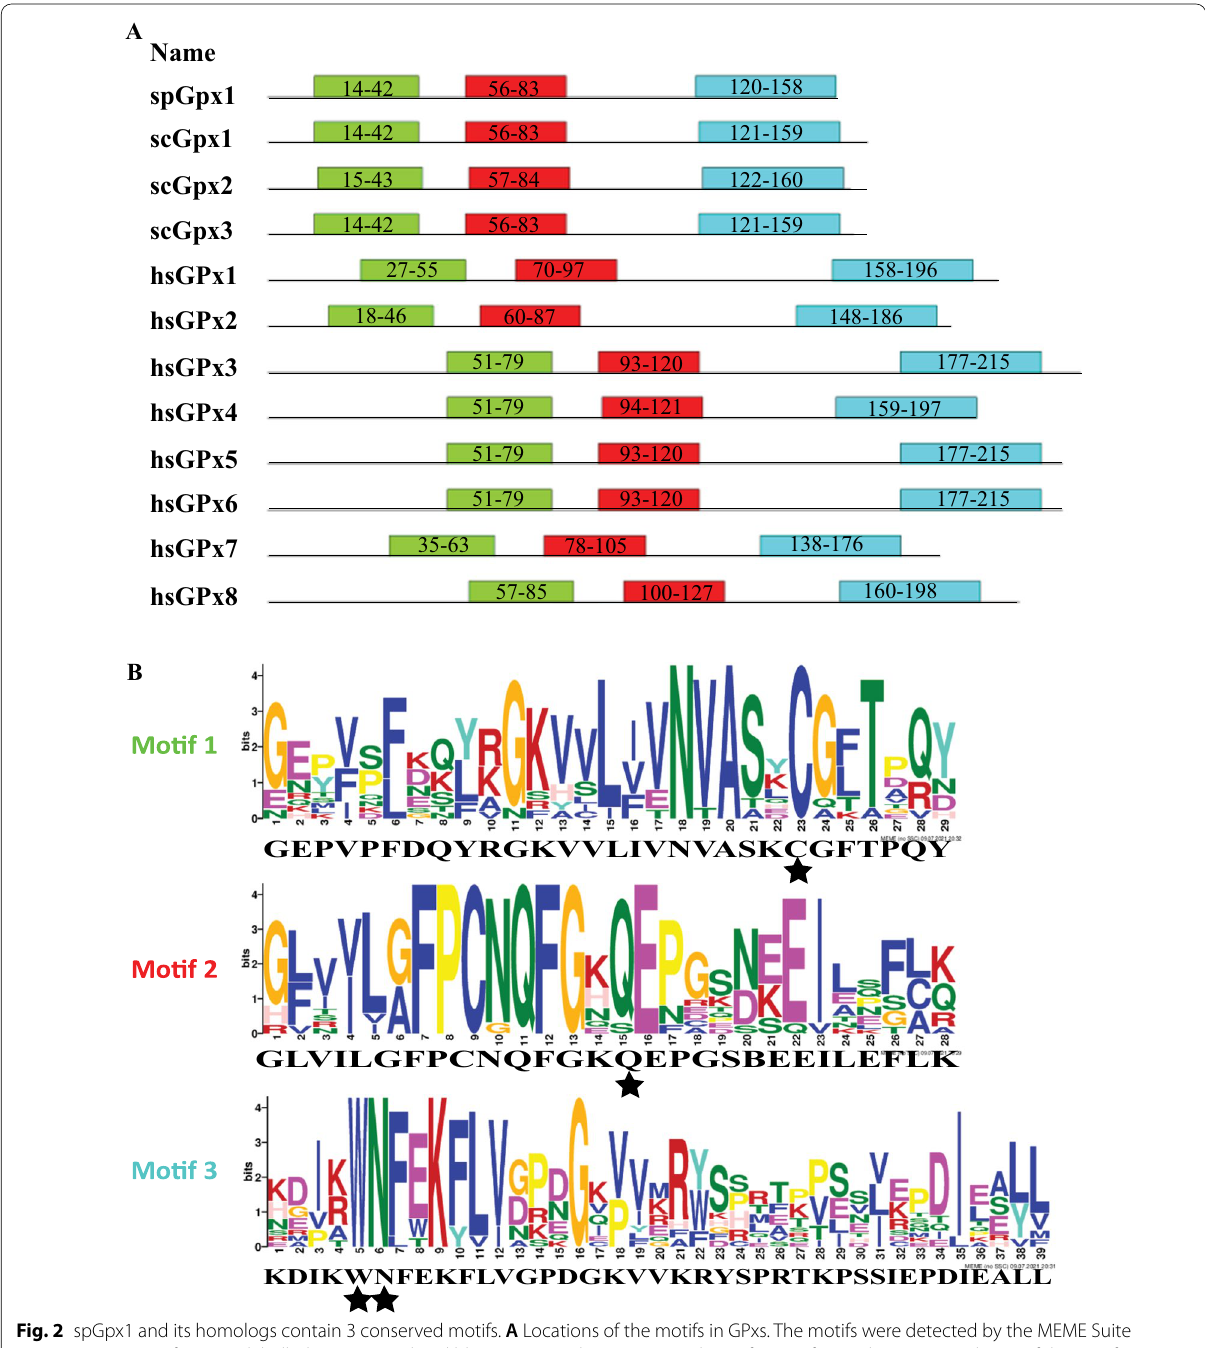
Fig. 2 spGpx1 and its homologs contain 3 conserved motifs. A Locations of the motifs in GPxs. The motifs were detected by the MEME Suite (Version 5.4.1). Motifs 1-3 are labelled in green, red and blue, respectively. B Sequence logos for Motifs 1-3. The sequence logos of the motifs derived from S. pombe , S. cerevisiae and human GPxs were generated using the MEME Suite. The height of each amino acid indicates the level of conservation at that position. Amino acid residues are highlighted according to the biochemical properties of the amino acid residues. The catalytic residues Cys, Gln, Trp and Asn (Tosatto et al. 2008) are indicated by